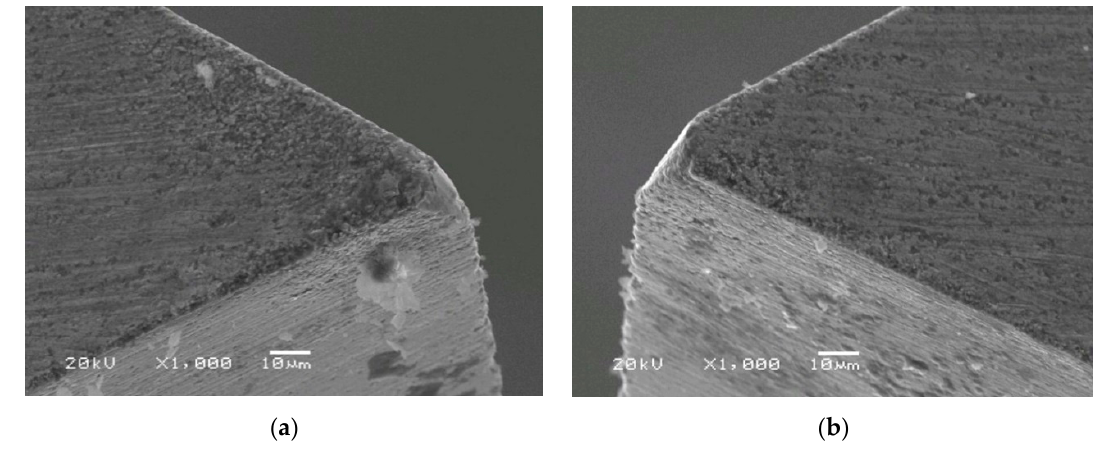
Figure 8. SEM photographs of the cutting edge after removing 10 layers of material with the following cutting parameters: Depth of cut a p = 1 µm, cutting speed V c = 80 m/min, feed rate f = 3 µm/rev; machining without ECA ( a ) and machining with ECA in variant B ( b ).